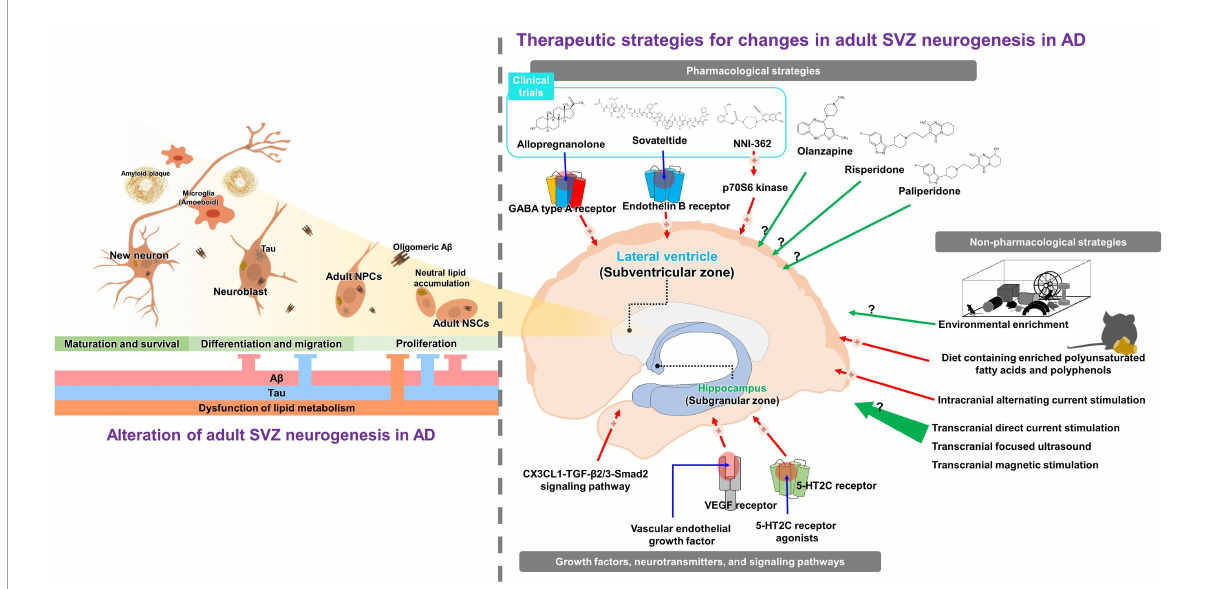
FIGURE1 Graphical abstract for pathologic roles and therapeutic implications on adult subventricular neurogenesis in Alzheimer’s disease (AD). The left panel indicates the pathologic roles of adult subventricular neurogenesis in AD. Accumulations of A β , tau, and lipid inhibit proliferation, differentiation, and migration of adult neural stem cells. The right panel presents therapeutic strategies for impaired adult subventricular neurogenesis in AD described in the review. Green arrows indicate approaches known to increase adult neurogenesis in healthy animals; however, their efficacy in AD has not yet been investigated. Red arrows indicate approaches known to rescue impaired adult neurogenesis in